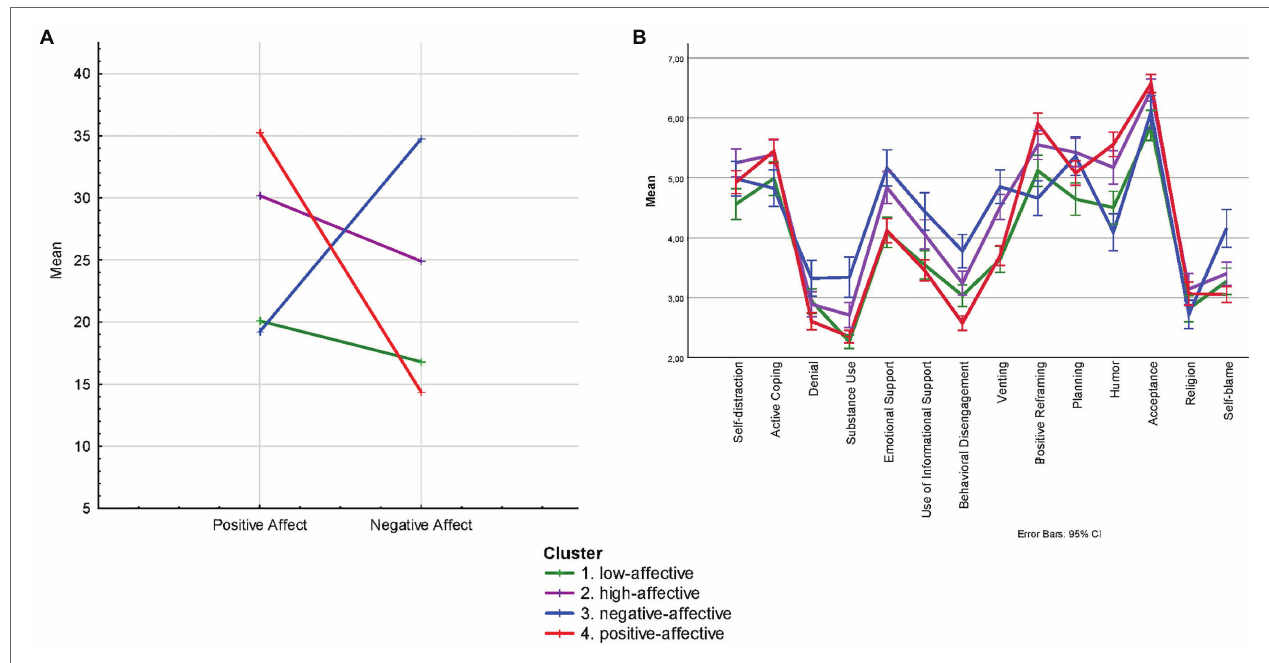
FIGURE 1 | Mean values for each Cluster (A) and profile of coping styles in the Cluster (B)